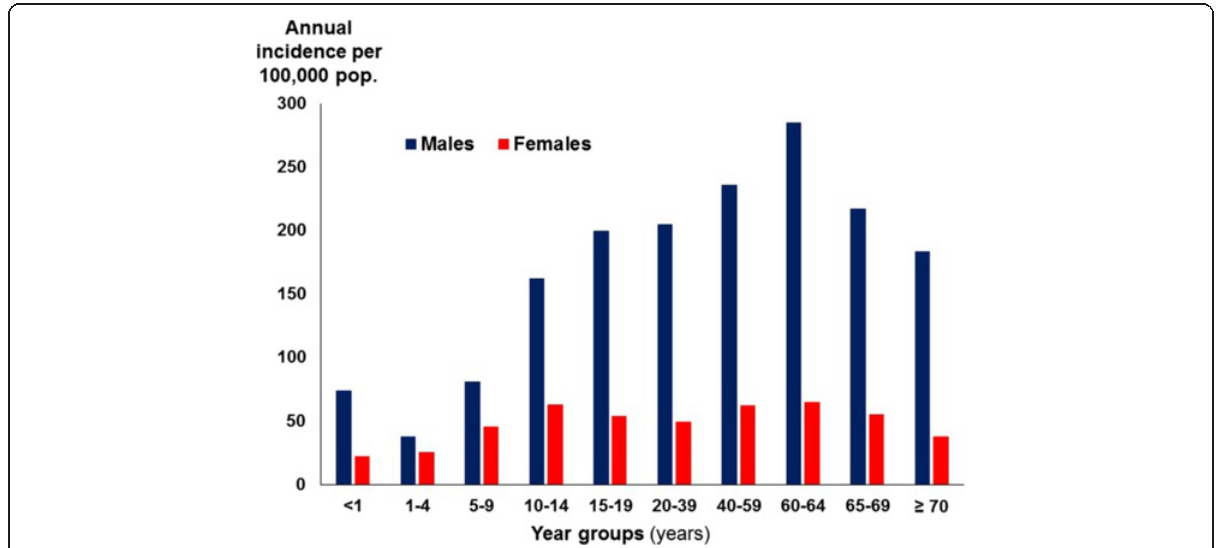
Fig. 13 Specific snakebite incidence according to age group and